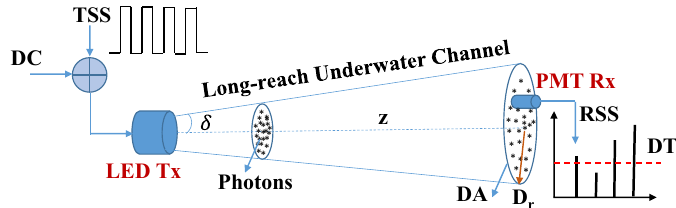
Figure 1. Proposed concept of long-reach UOWC using LED and PMT. DC: direct current, TSS: transmitted signal sequence, DA: detection area, RSS: received signal sequence, DT: decision threshold. 𝛿 is the divergence half-angle. z is the transmission distance. D r is the radius at the detection area.